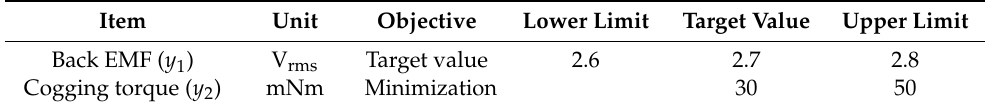
50 Table 7. Final optimal results. Design Variable